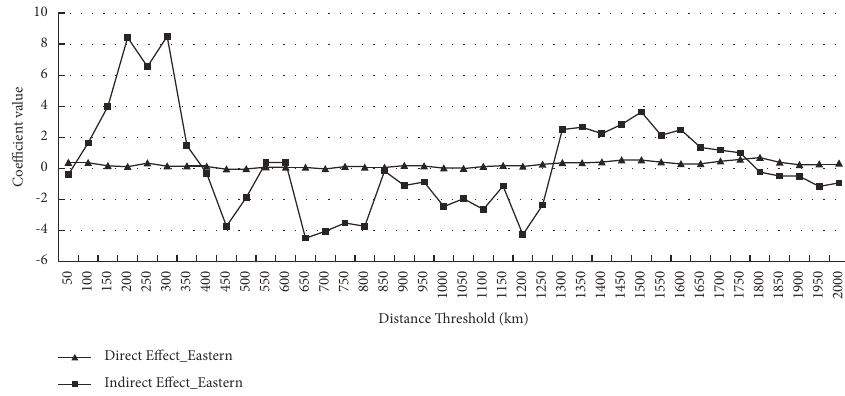
Figure 8: Spatial trends of the impact of the eastern region’s digital economy on urban